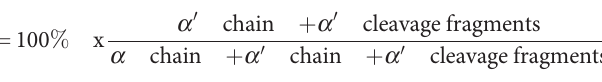
FIGURE 1 | A schematic explanation of the study